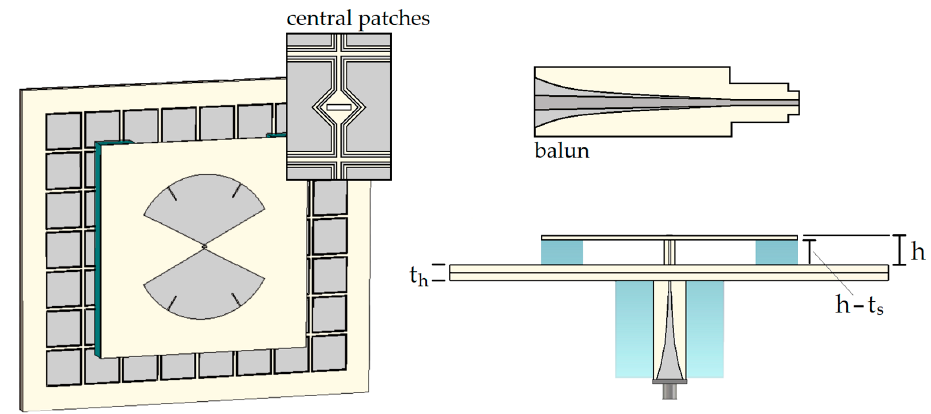
Figure 12. Final design: the AMC unit cell parameters are defined in Table 1; the bow-tie parameters are shown in Table 2; the inset shows the hole to pass the balun in the central patches. A 3:1 impedance ratio exponential taper balun [38] etched on the same material as